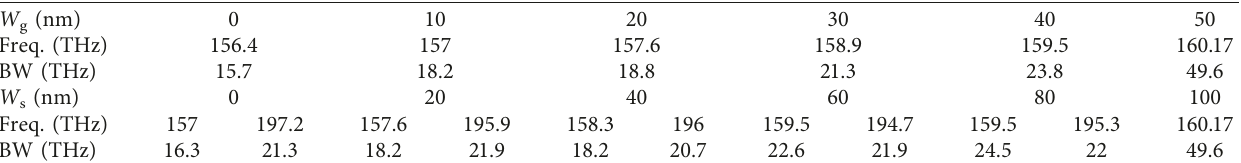
Figure 3: The ratio of reflected wave to the incident wave, S 11 , versus operation frequency for different slots thicknesses. (a) W g 30, 40, 50)nm. (b) W s � (0, 20, 40, 60, 80, 100)nm. Table 1: Comparison at different slots